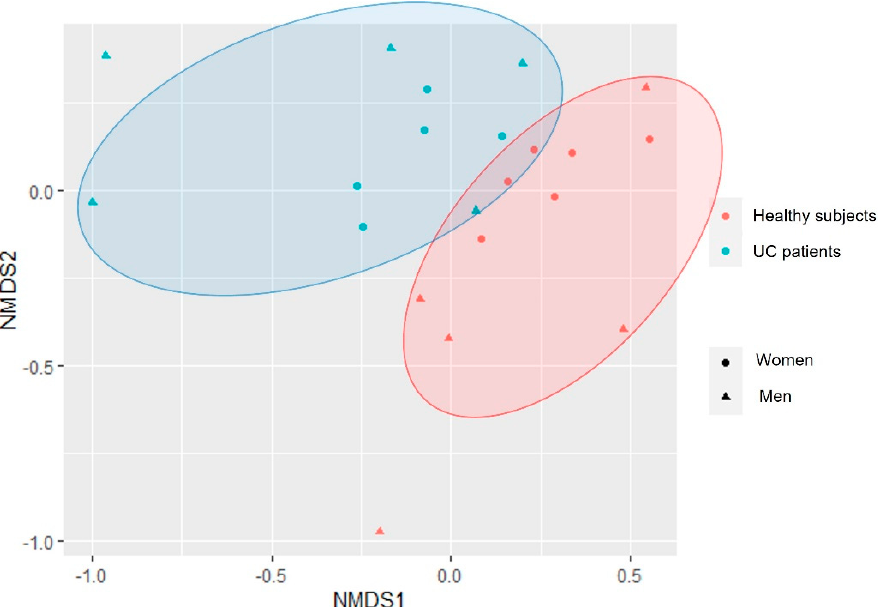
Figure 2. Beta diversity analysis following the NMDS Bray–Curtis method for the UC patients and healthy subjects.